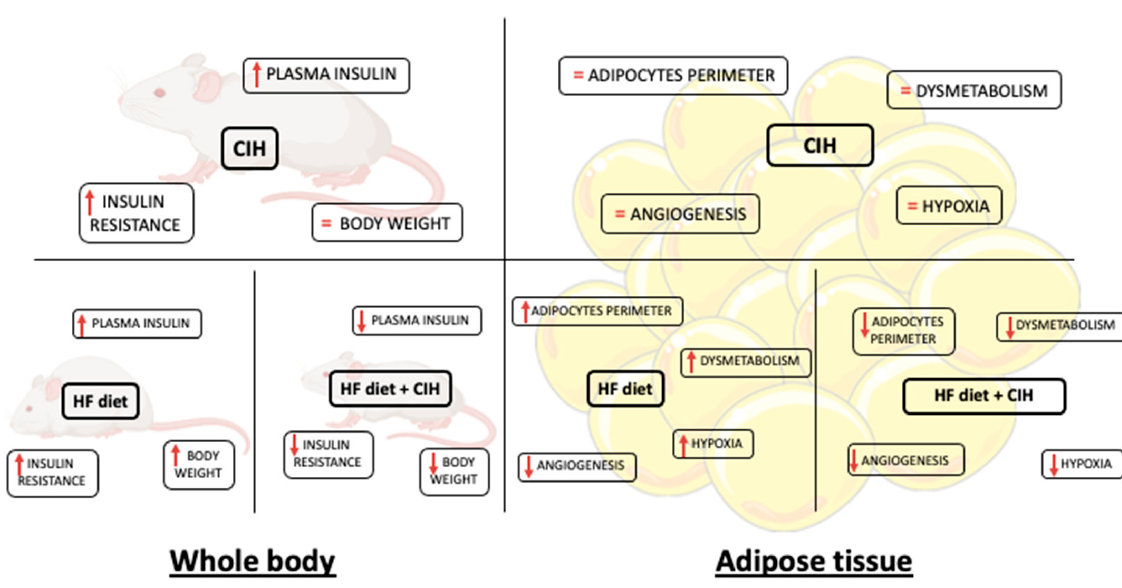
Figure 8. Schematic figure representing the major findings of the effect of chronic intermittent hypoxia (30 hypoxic (5% O 2 ) cycles, 8 h/day) for 15 days, on body weight and whole-body insulin sensitivity and levels and adipose tissue function in control and obese rats.